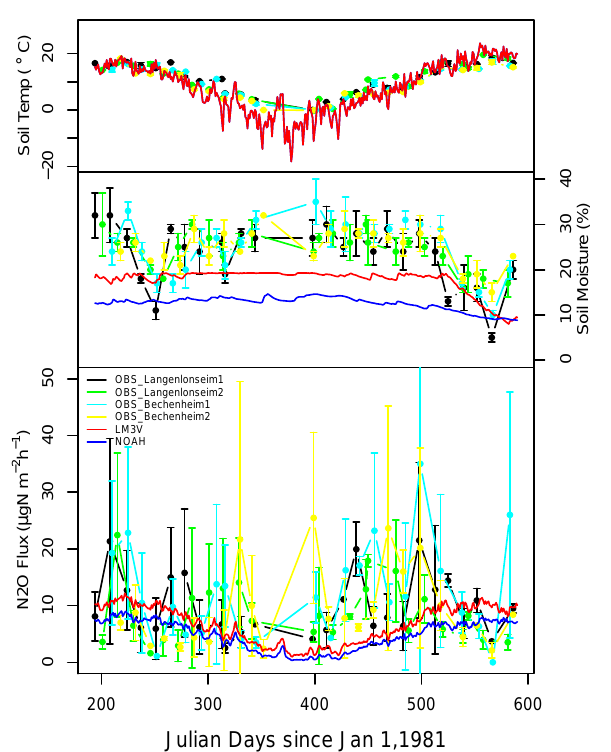
Figure 6. Comparison of (a) soil temperature (2cm from obser- vation and 1cm from model) in ◦ C; (b) soil moisture (2cm from observation and root zone from model) in % and (c) soil N 2 O emis- sions inµgNm − 2 h − 1 from observations and model outputs at four forest sites from Germany (50 ◦ N, 8 ◦ E), taken from Schmidt et al. (1988). Shown are modelled results from two WFPS schemes (LM3V-SM and NOAH-SM) similar as in Fig. 4.